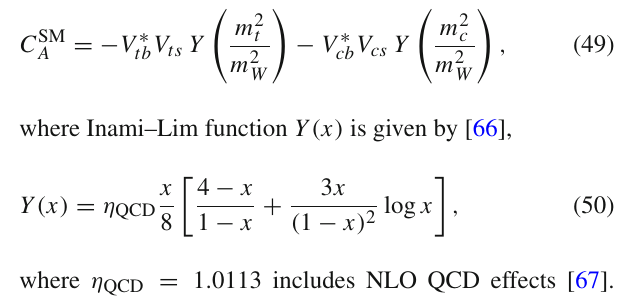
| for λ χ = 2 in the m − a 12